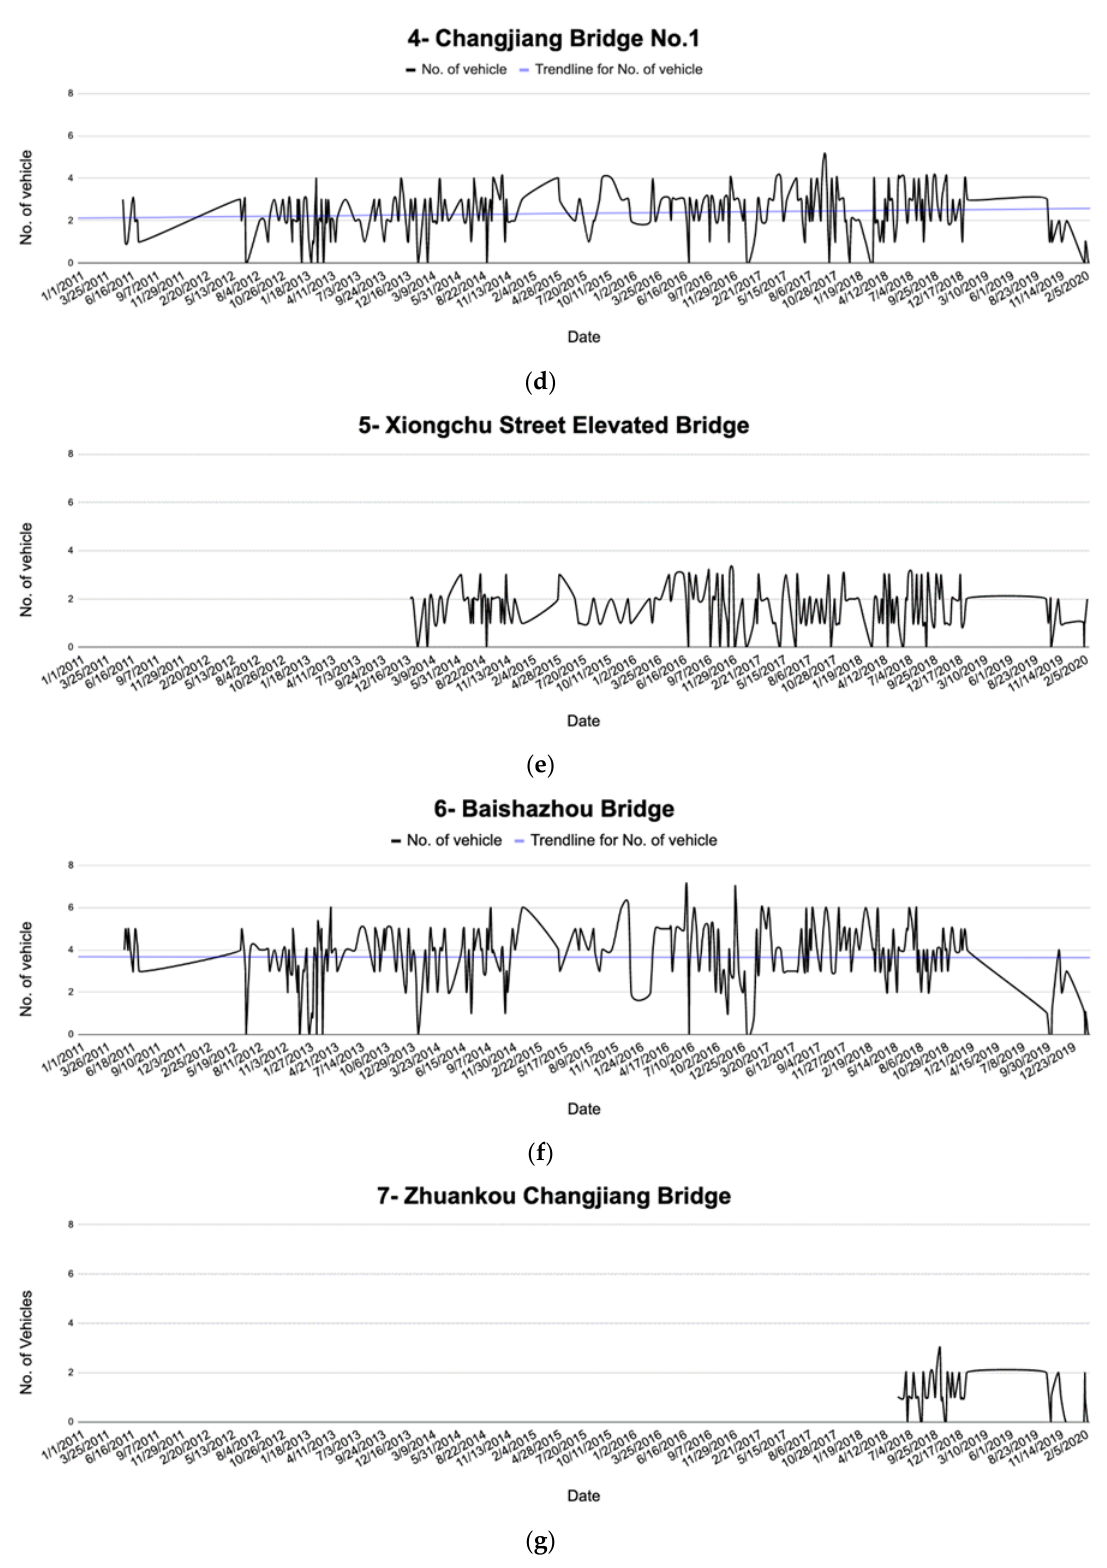
Figure 10. Variation in the number of vehicles on the seven bridges crossing the Yangtze river within the city of Wuhan, detected since May 2011 in each COSMO-SkyMed acquisition at 06:00 a.m. local time.